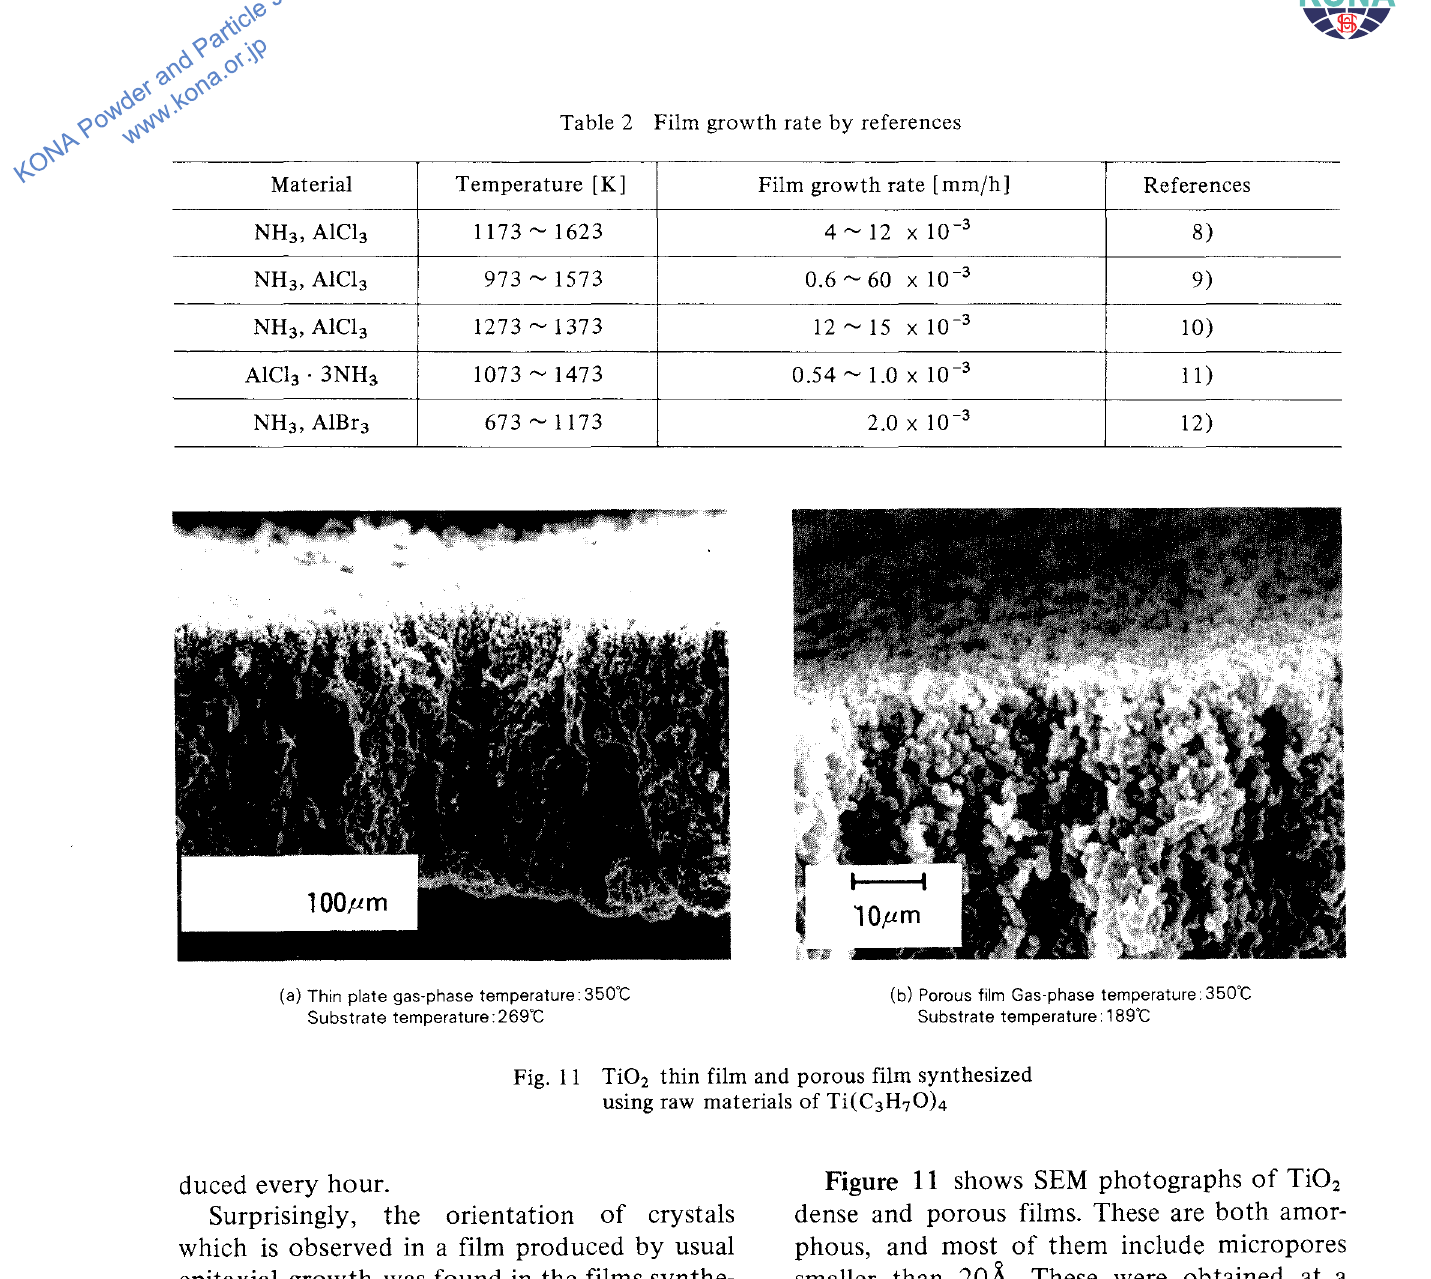
Fig. 11 Ti0 2 thin film and porous film synthesized using raw materials of Ti( C3H 7